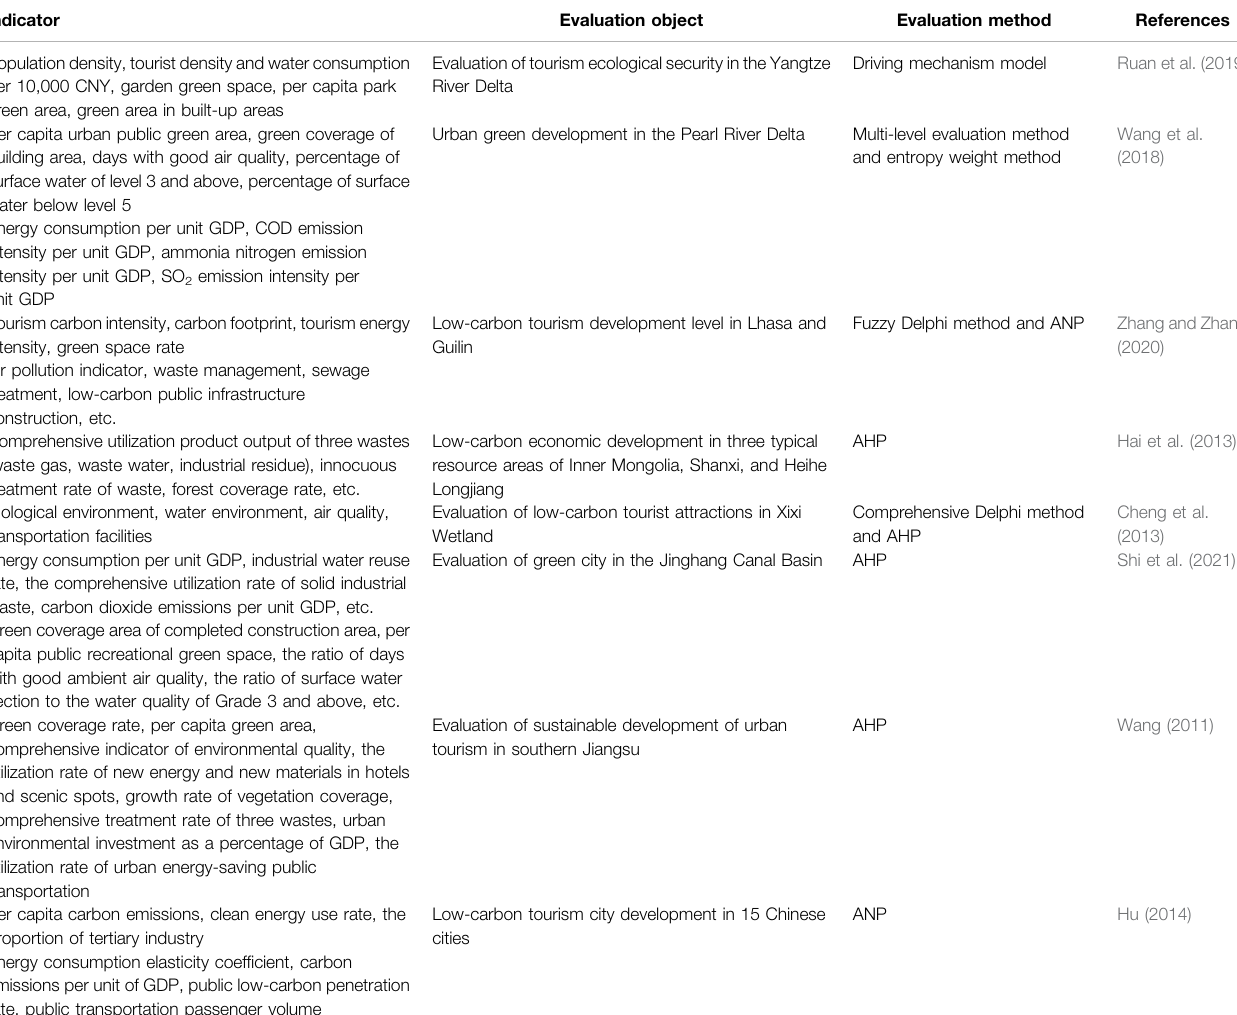
TABLE 2 | Indicators of environmental